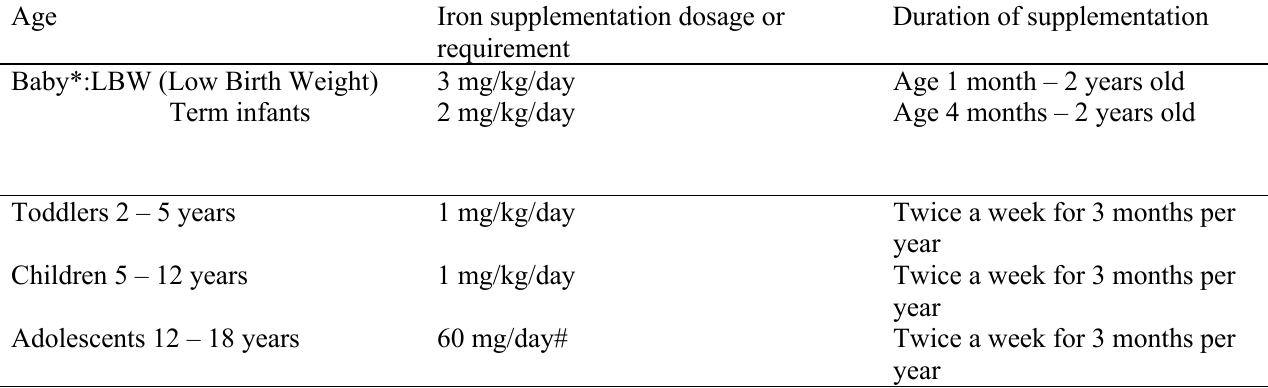
Table 4 . Elemental iron supplementation dosage and duration of supplementation 21 Age Iron supplementation dosage